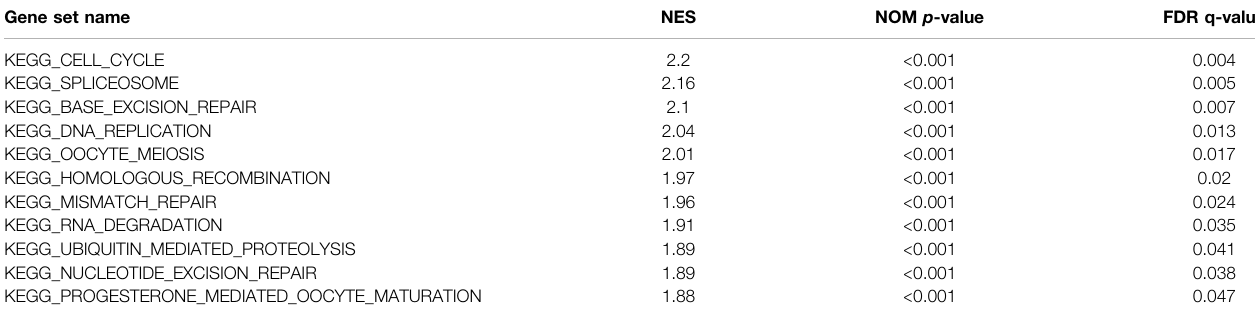
TABLE 3 | Gene sets enriched in the ASF1B high-expression phenotype in HCC.